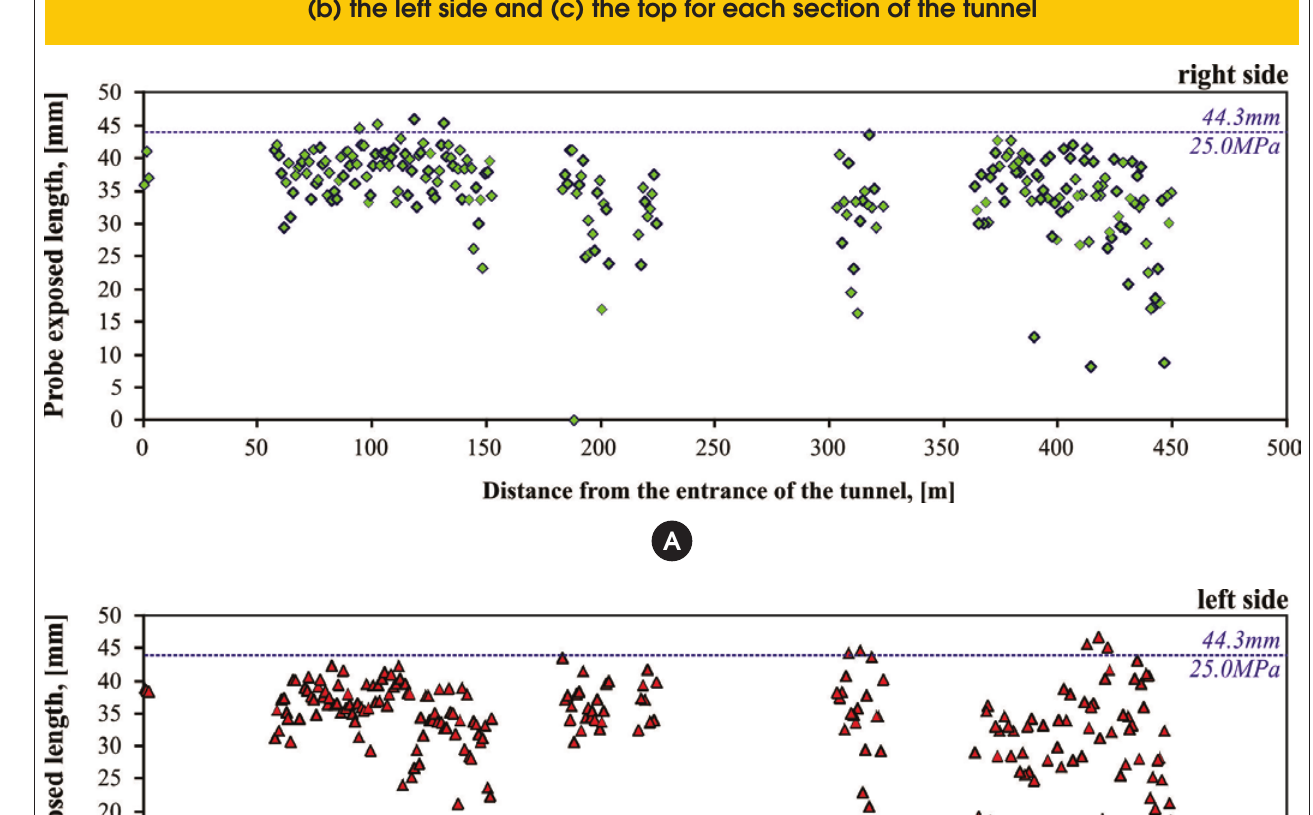
Figure 8 – Individual values of exposed length of the pin for (a) the right side, (b) the left side and (c) the top for each section of the